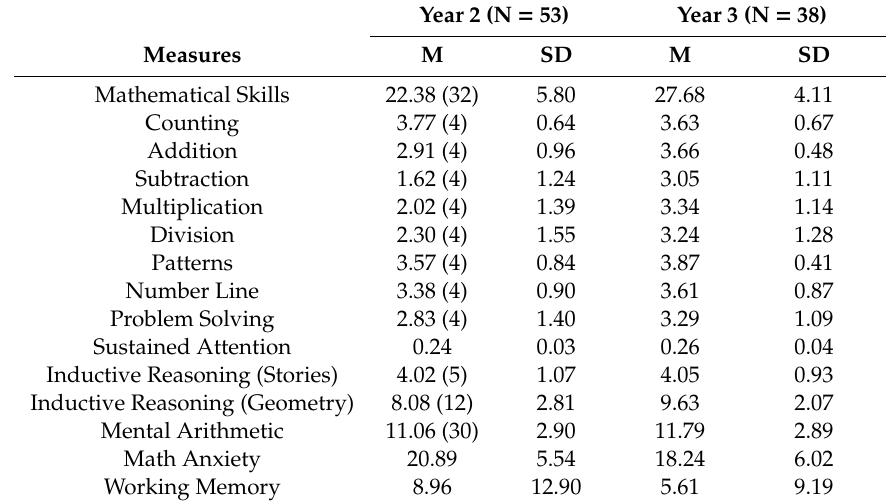
Table 3. Descriptive statistics for mathematical measures and cognitive skills in terms of the school grade.